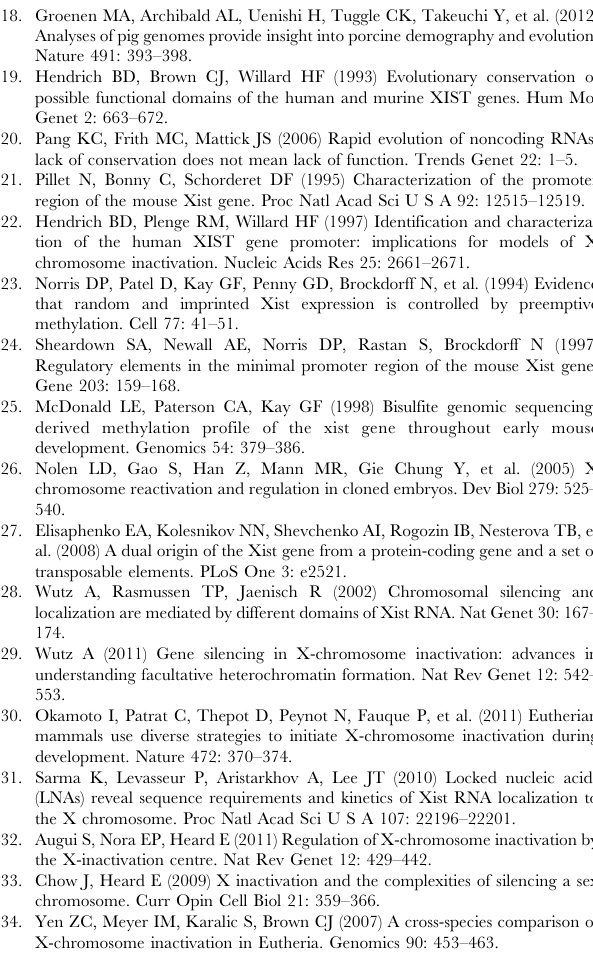
Figure S5 Illumina sequencing coverage of porcine XIST mRNA expression. The entire region of XIST mRNA and upstream/downstream regions was used as a reference sequence for Illumina sequence alignment to show mRNA sequence distribution. The Illumina RNA-Seq was obtained from three tissues of different female individuals (F1 and F2). Sequencing depth was normalized using the total number of aligned reads.